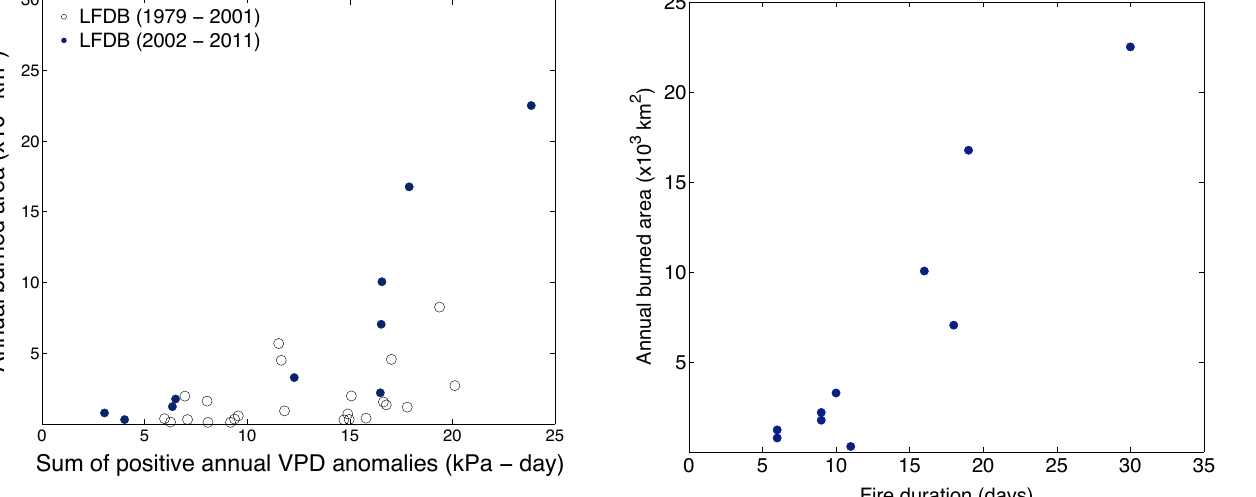
Figure 10. Scatterplot of the sum of positive VPD anomalies dur- ing DOY 150–240 against annual burned area for 2002–2011 (blue dots) extracted from Alaska LFDB and subtracting unburnt islands within fire perimeters and 1979–2001 (black asterisks) from the Alaska LFDB.